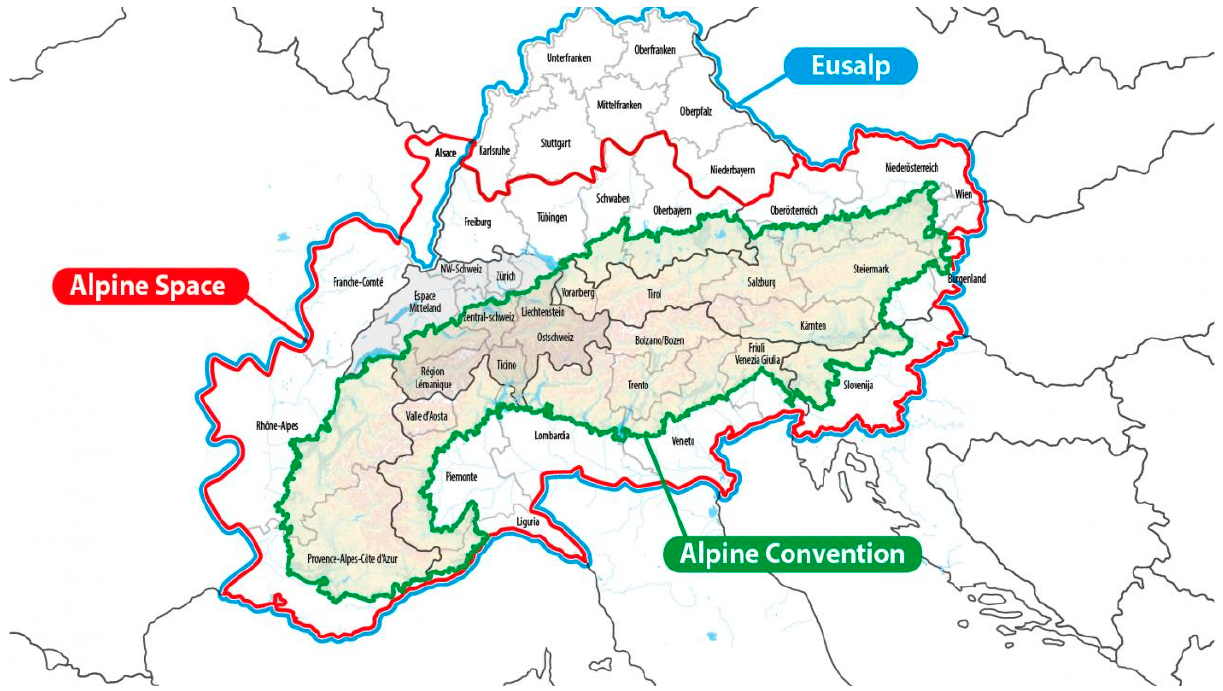
Figure 3. The Alpine Convention, the Alpine Space, and the EUSALP in the Alpine area. Source: EUSALP, direct contact, 2020.